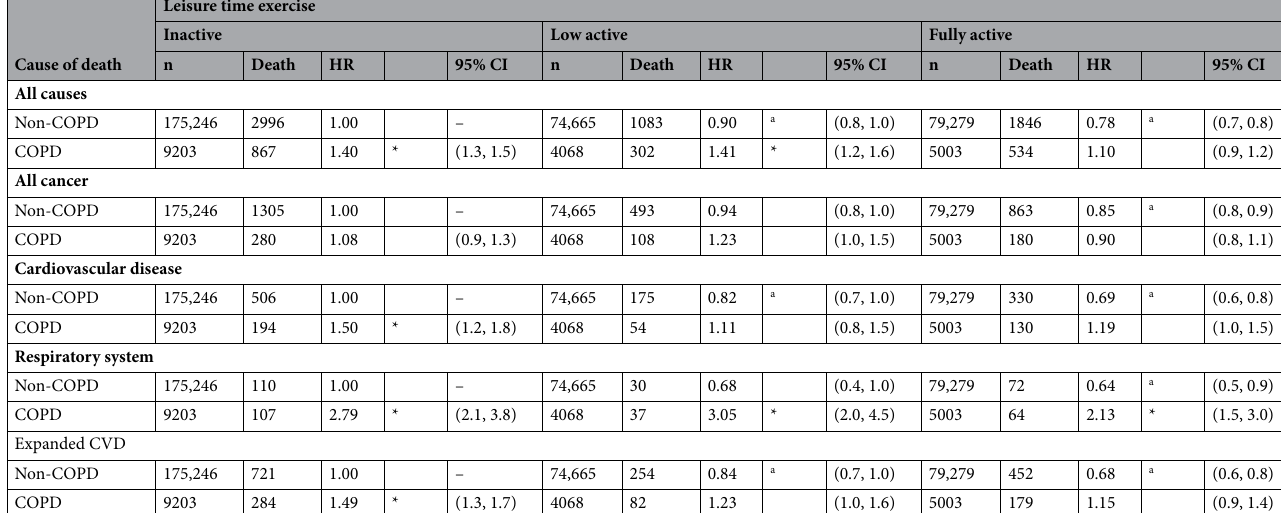
Table 4. The comparison of mortality risk by amount of leisure time exercise between participants with or without COPD. HRs were adjusted for age, gender, education, BMI, smoking, anemia, hypertension, and blood glucose *Indicates a significantly ( p < 0.05) higher mortality compared to the reference group. a indicates a significantly ( p < 0.05) lower mortality compared to the reference group. The reference group is Non-COPD subjects who had inactive